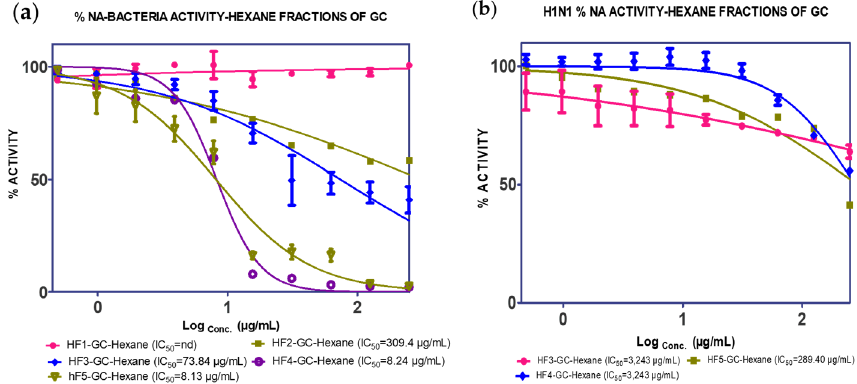
Figure 2. NA inhibition activity of n -hexane fractions of GCL against ( a ) C. perfringens –NA and ( b ) H 1 N 1 -NA.